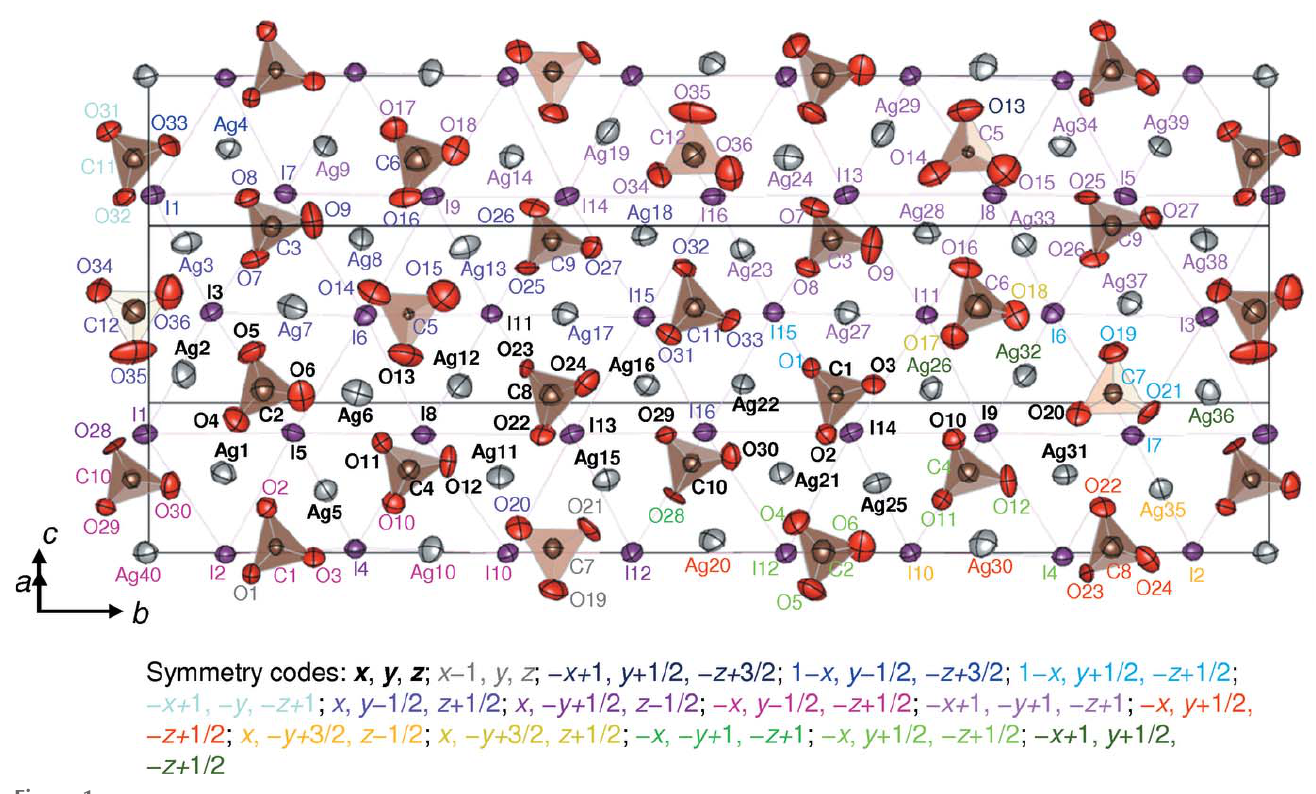
Figure 1 Arrangement of Ag and I atoms and CO 3 groups in the crystal structure of Ag 10 (CO 3 ) 3 I 4 projected on (101). Displacement ellipsoids are drawn at the 99% probability